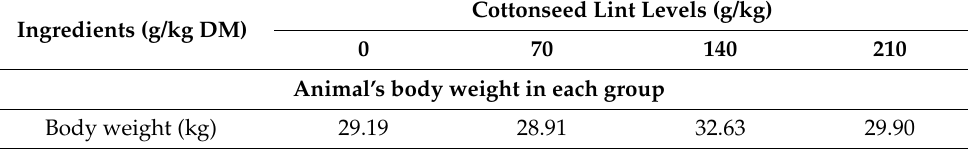
Table 3. Cont. Ingredients (g/kg